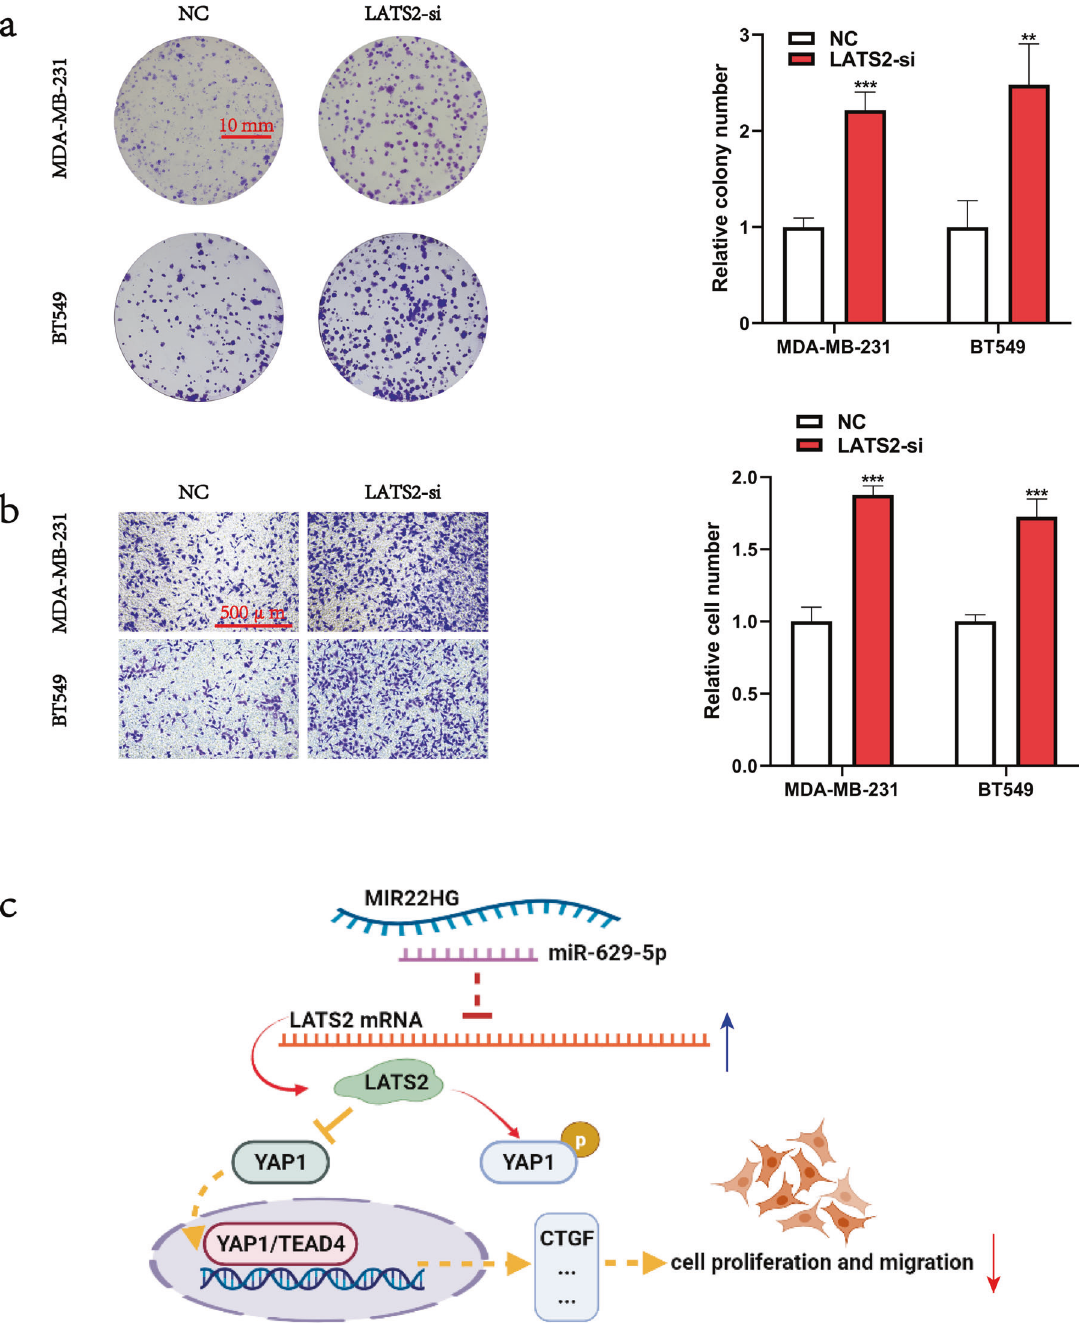
Fig. 7 LATS2 knockdown promoted the proliferation and migration of breast cancer cells. a Colony formation assay was used to determine the viability of MDA-MB-231 and BT549 cells after LATS2 knockdown. b Transwell assay was performed to evaluate the migration ability of MDA-MB-231 and BT549 cells after LATS2 knockdown (100× magni fi cation). c A scheme of the proposed molecular mechanisms. MIR22HG stabilizes LATS2 by counteracting the miR-629-5p-induced degradation of LATS2 mRNA, consequently resulting in the promotion of LATS2- dependent YAP1 phosphorylation and YAP1 inactivation. *** P < 0.001. All experiments were repeated thrice.